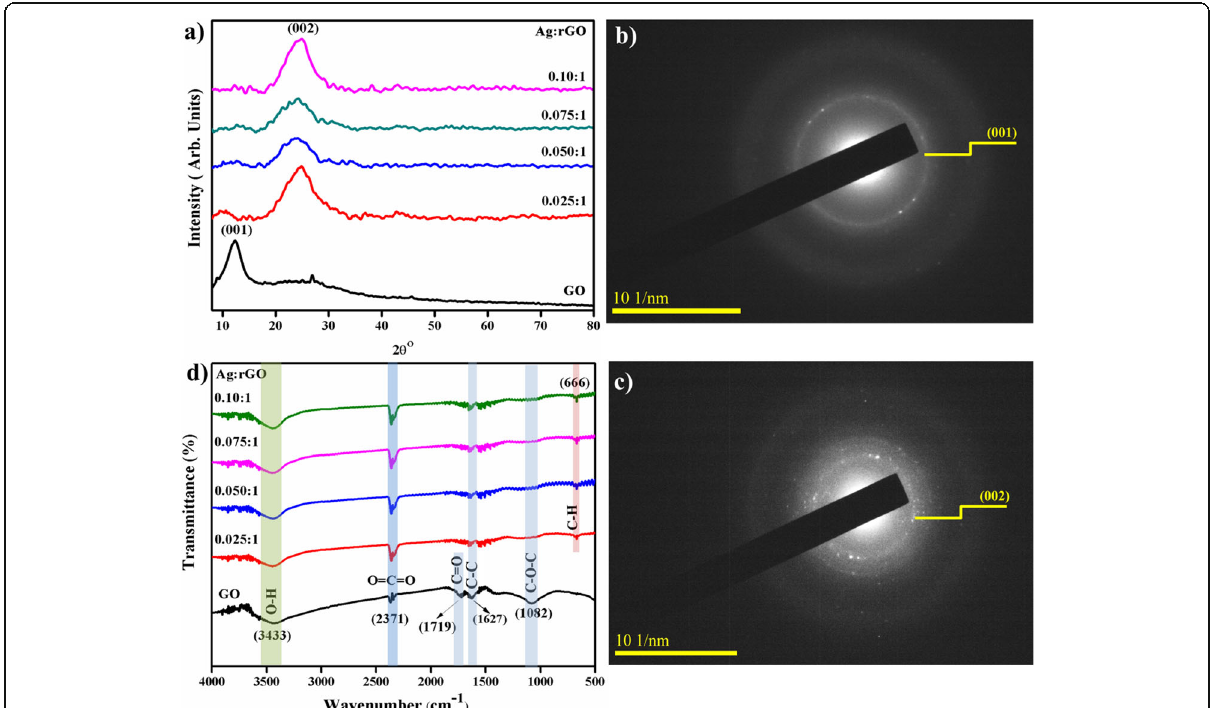
Fig. 3 a XRD pattern. b , c SAED rings of as-prepared and Ag-doped RGO ( b ) 0:1 ( c ) 0.010:1. d FTIR